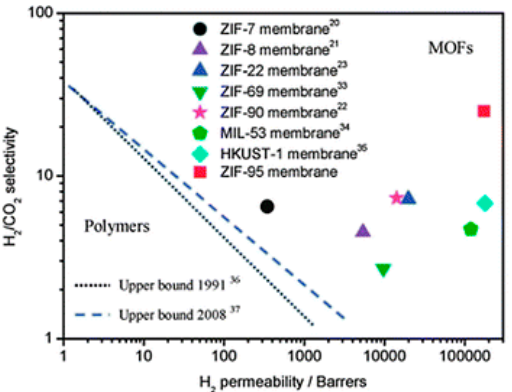
Figure 23. H 2 /CO 2 selectivity versus H 2 permeability for polymeric and MOF membranes (adapted with permission from ref. [125]).